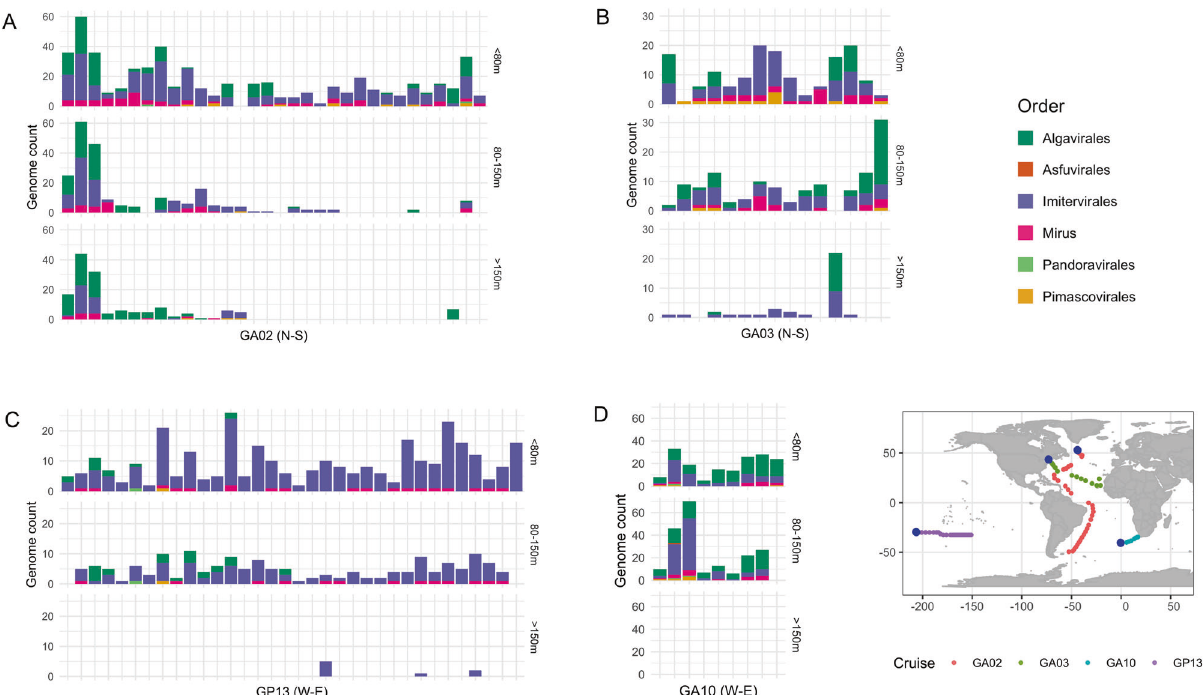
Fig. 3 Distribution of giant viruses in each transect. Giant virus distribution along the transects ( A ) GA02 ( B ) GA03 ( C ) GA10 ( D ) GP13. Each column represents a sampling location. The y-axis shows the number of different viral genomes that were recovered at a given location, separated into three depth ranges (2 – 80 m, 80 – 150 m, and 150 – 5500 m). Locations are arranged in increasing distance from left to right on the x-axis, based on their distance from the starting location and follow the indicated orientation (N to S for GA02 and GA03, W to E for GA10 and GP13). There are no samples collected at >150 m in the GA10